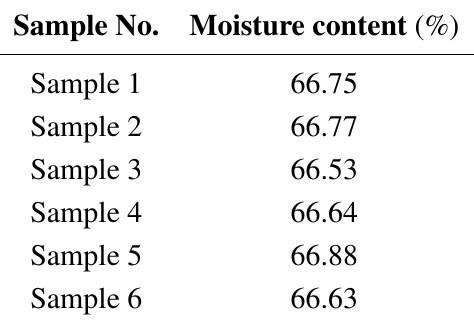
Table 4. The moisture content for the silage bale samples. Moisture content is high and stable leading to a high permittivity and